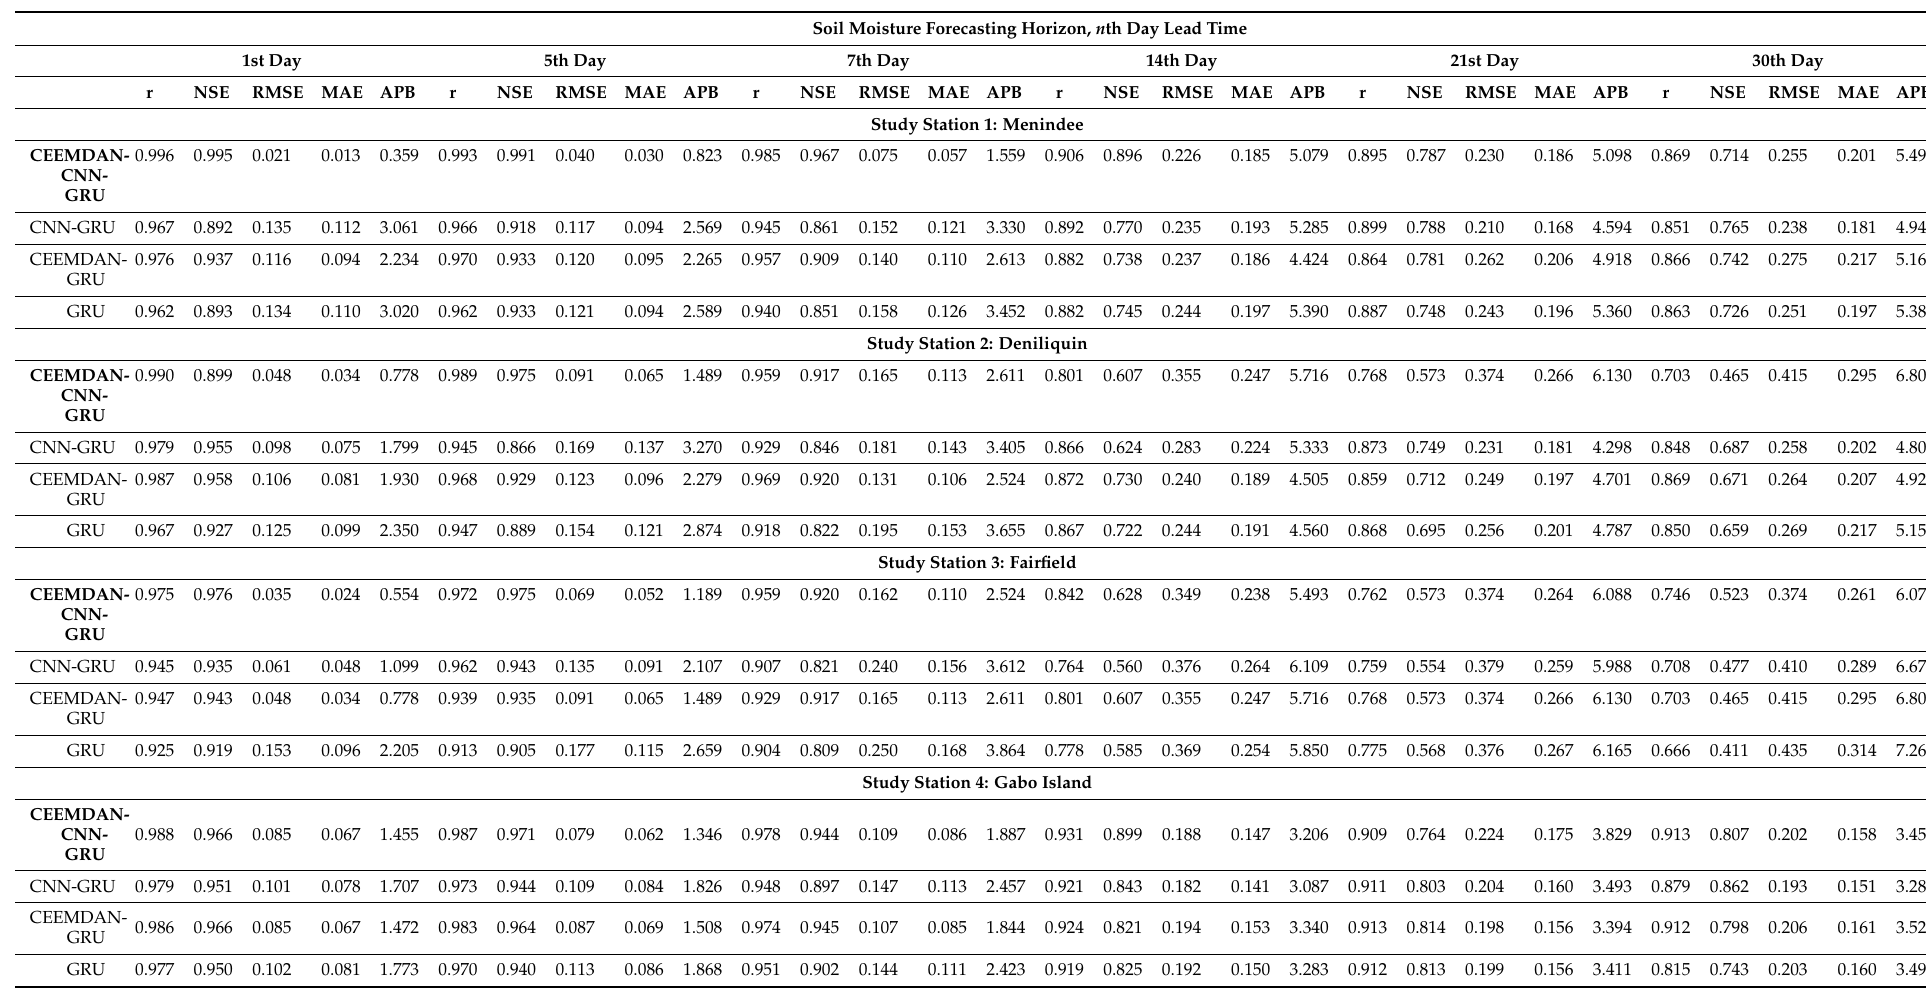
Table 4. Evaluation of hybrid CEEMDAN-CNN-GRU vs. benchmark (CNN-GRU, CEEMDAN-GRU, GRU) models for the specific case of Menindee study site. The correlation coefficient ( r ), root mean square error ( RMSE ; Kg m − 2 ), mean absolute error ( MAE ; Kg m − 2 ), and Nash-Sutcliffe coefficient, NS ) is computed between forecasted and observed surface soil